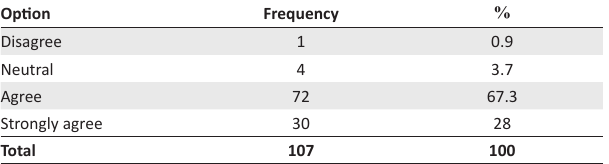
TABLE 5: Frequency distribution of the overall opinion on information management.